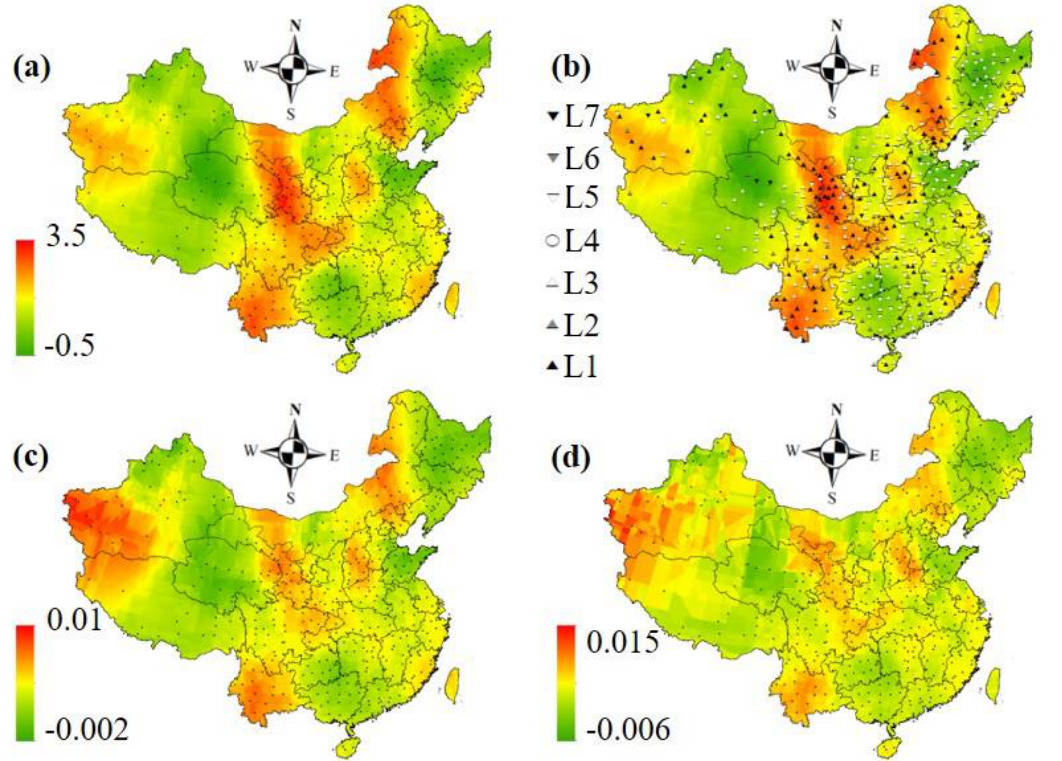
Figure 3. Spatial distribution maps for the trend analysis of ET 0 : ( a ) M – K Z S , ( b ) significance, ( c ) Sen’s slope , and ( d ) linear trend. L1: significant-increase (1%); L2: significant-increase (5%); L3: increase; L4: no trend; L5: decrease; L6: significant-decrease (5%); L7: significant-decrease (1%).